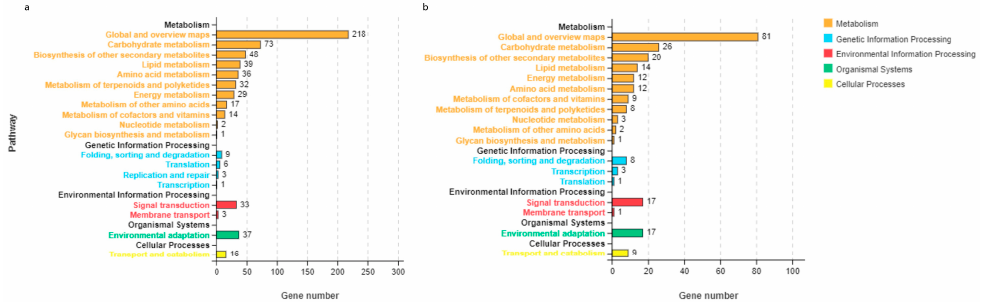
(<0 ◦ C) treatment Figure 6. KEGG results for DEGs between CK and the ( a ) CT1 and CT2 (>0 °C) and ( b ) CT3 and CT4 (<0 °C) treatment groups.